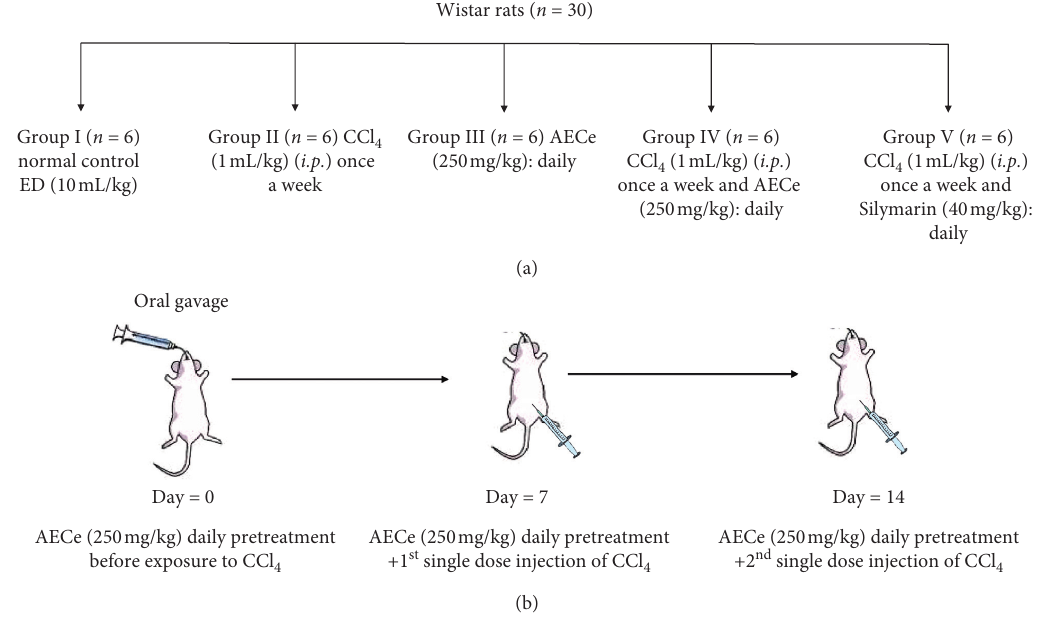
Figure 1: Schematic representation of (a) the experimental design; (b) the timeline chart for AECe treatment in the experimental rats injected with CCl 4 (Group IV). n: number of